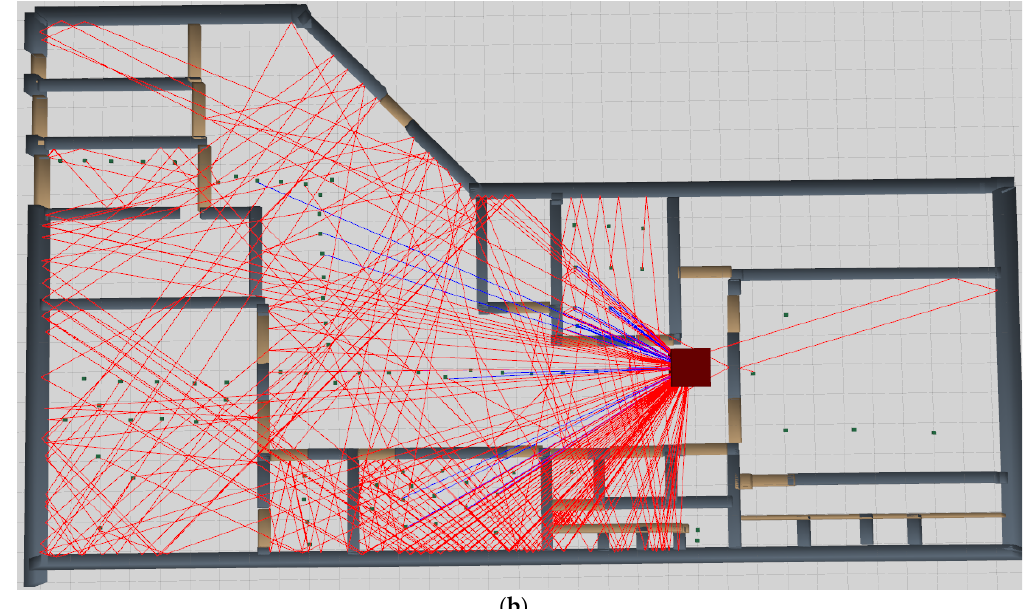
Figure 4. ( a ) 2-D and ( b ) 3-D simulation layout using the SBRT method.